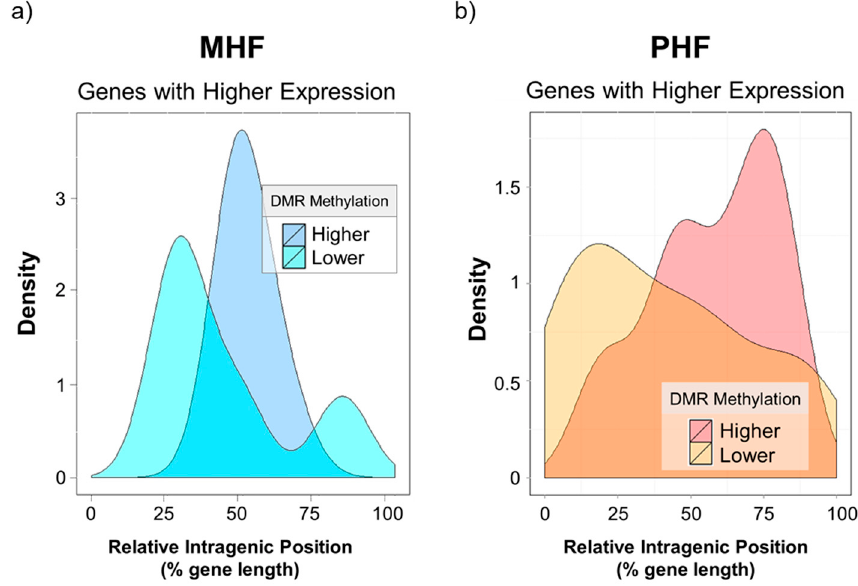
Figure 7. Gene expression is associated with intragenic DMR position. X-axis indicates intragenic DMR position relative to the gene’s transcription start site (x = 0) and transcription end site (x = 100). Y-axis represents the density of DMRs. ( a ) the density plot depicts DMGs that were more highly expressed in the MHF group. Higher gene expression in MHF was associated with lower DNA methylation in the middle of the intragenic region. ( b ) The density plot shows DMGs that were more highly expressed in the PHF group. Higher PHF expression was associated with higher downstream DNA methylation and lower DNA methylation near the TSS.